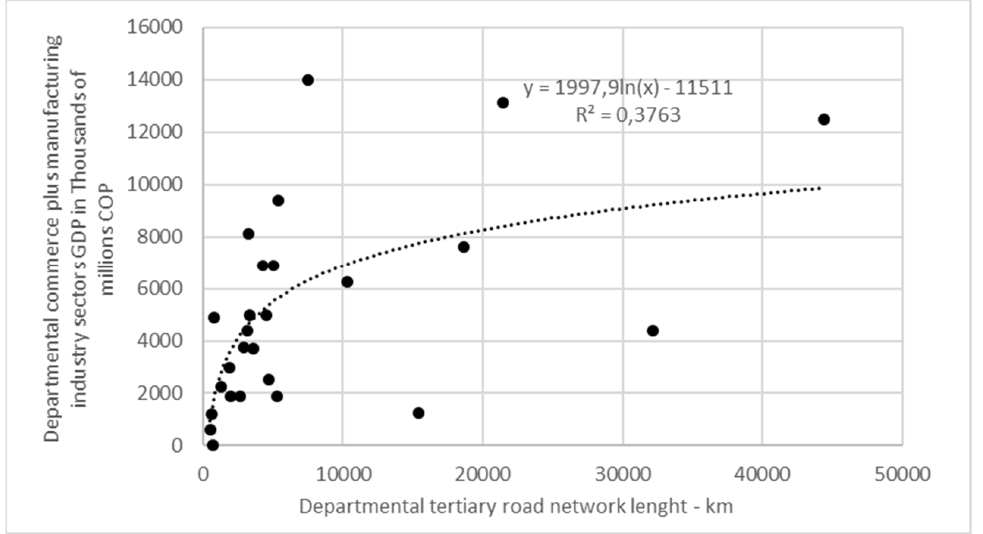
Figure 10. Logarithmic regression between commerce plus manufacturing industry sector GDP and tertiary roadway network, according to the department.